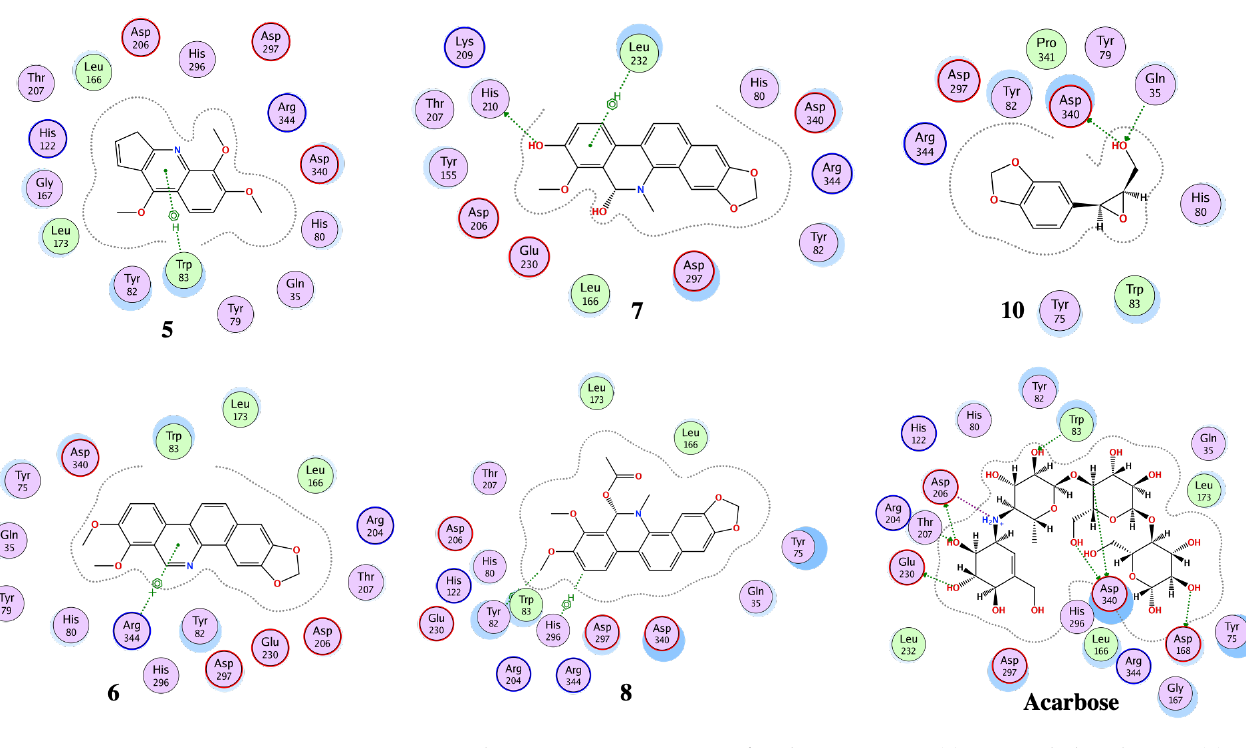
Figure 4. The 2D interactions of Skimmianine ( 5 ), Norchelerythrine ( 6 ), 6-Acetonyldihydrochelerythrine ( 7 ), and 6-Hydroxy-N-methyldecarine ( 8 ) alkaloids, 2,3-Epoxy-6,7-methylenedioxyconiferol ( 10 ), and the reference acarbose with α -amylase enzyme (PDB ID: 7TAA).